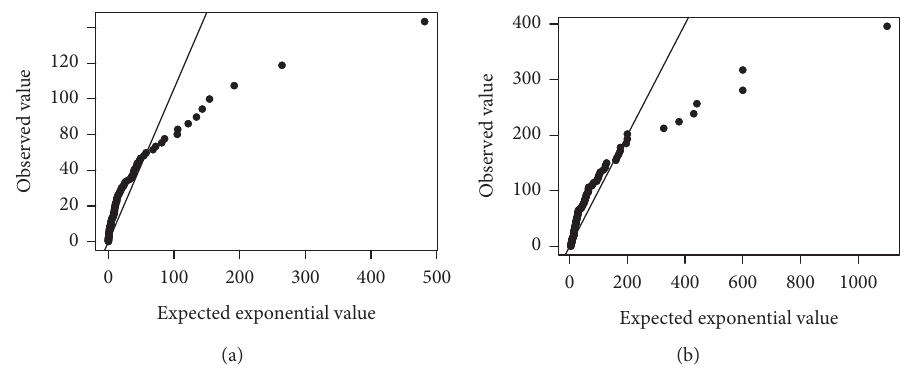
Figure 1: Exponential Q-Q plot of damage areas (a) and exponential Q-Q plot of deaths (b).